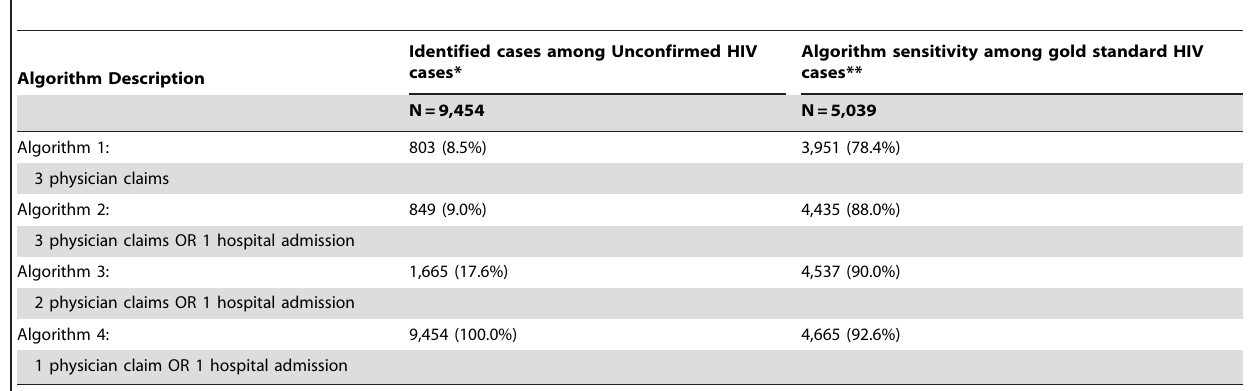
Table 2. Comparison of case-finding algorithms.